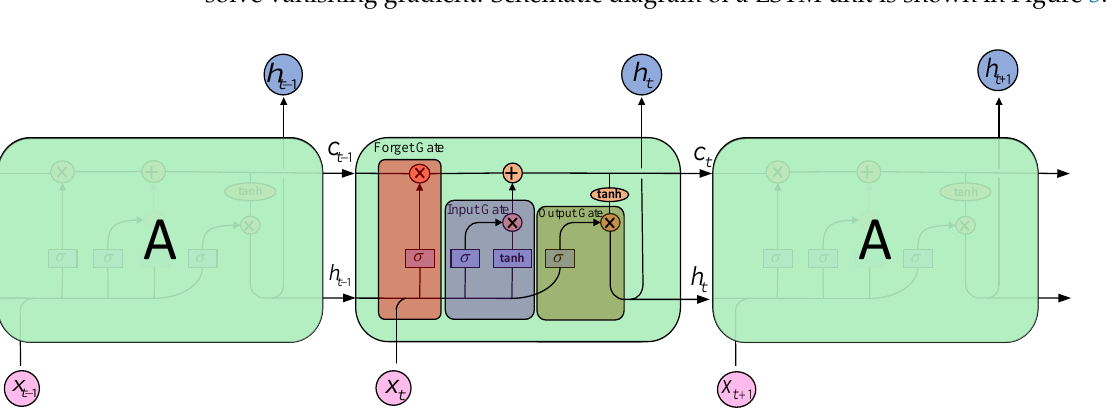
Figure 3. LSTM structure diagram.